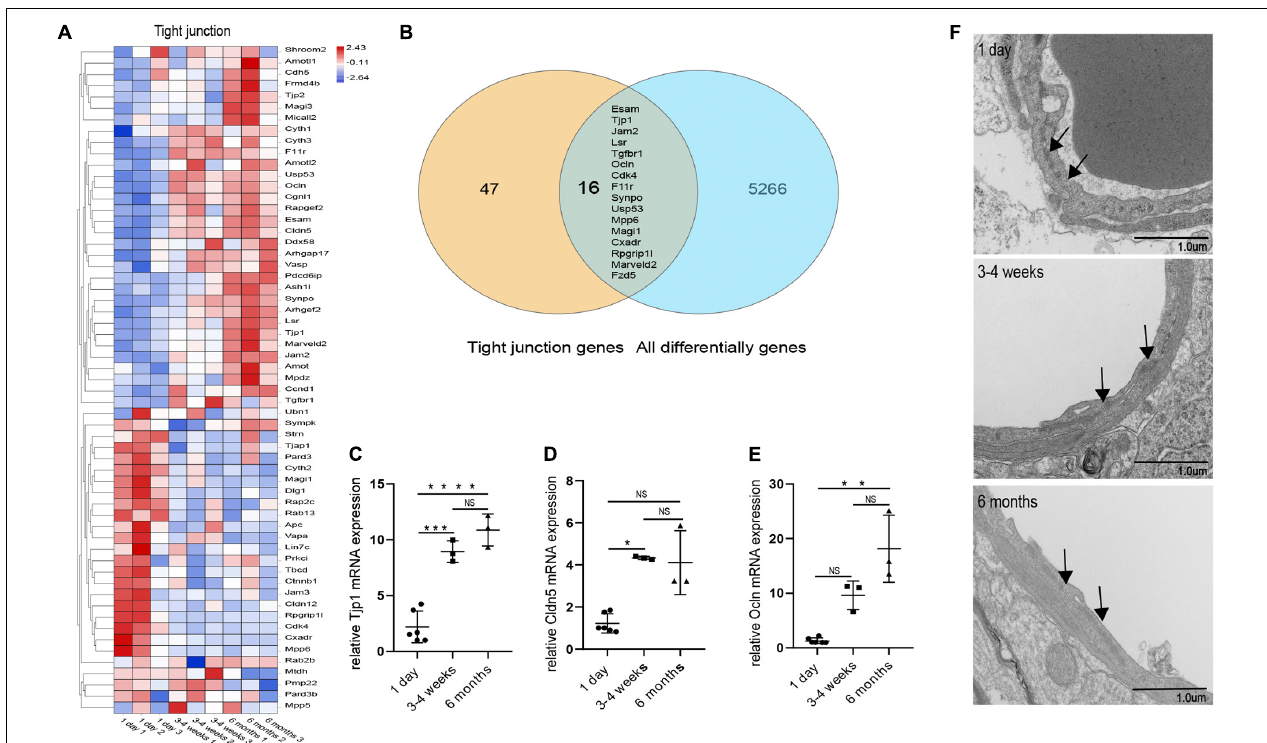
FIGURE 6 | Changes in microvascular endothelial TJs during development. (A) Heat map of genes related to BBB TJ components at three different time points. (B) Venn diagram of the number of all differentially expressed genes and BBB TJ component genes. All differentially genes represent the differential genes that are compared in pairs between the three groups. (C) The expression of tjp1 was examined by qRT-PCR ( n = 3–6). (D) The expression of cldn5 was examined by qRT-PCR ( n = 3–6). (E) The expression of ocln was examined by qRT-PCR ( n = 3–6). (F) Representative images of the ultrastructure of the microvasculature in the 1-day-old, 3–4-week-old and 6-month-old groups. Mean values ± SD, NS, not significant; * p < 0.05, ** p < 0.01, *** p < 0.001 and **** p < 0.0001 compared to the Sham group; one-way ANOVA followed by Dunnett’s post hoc test.